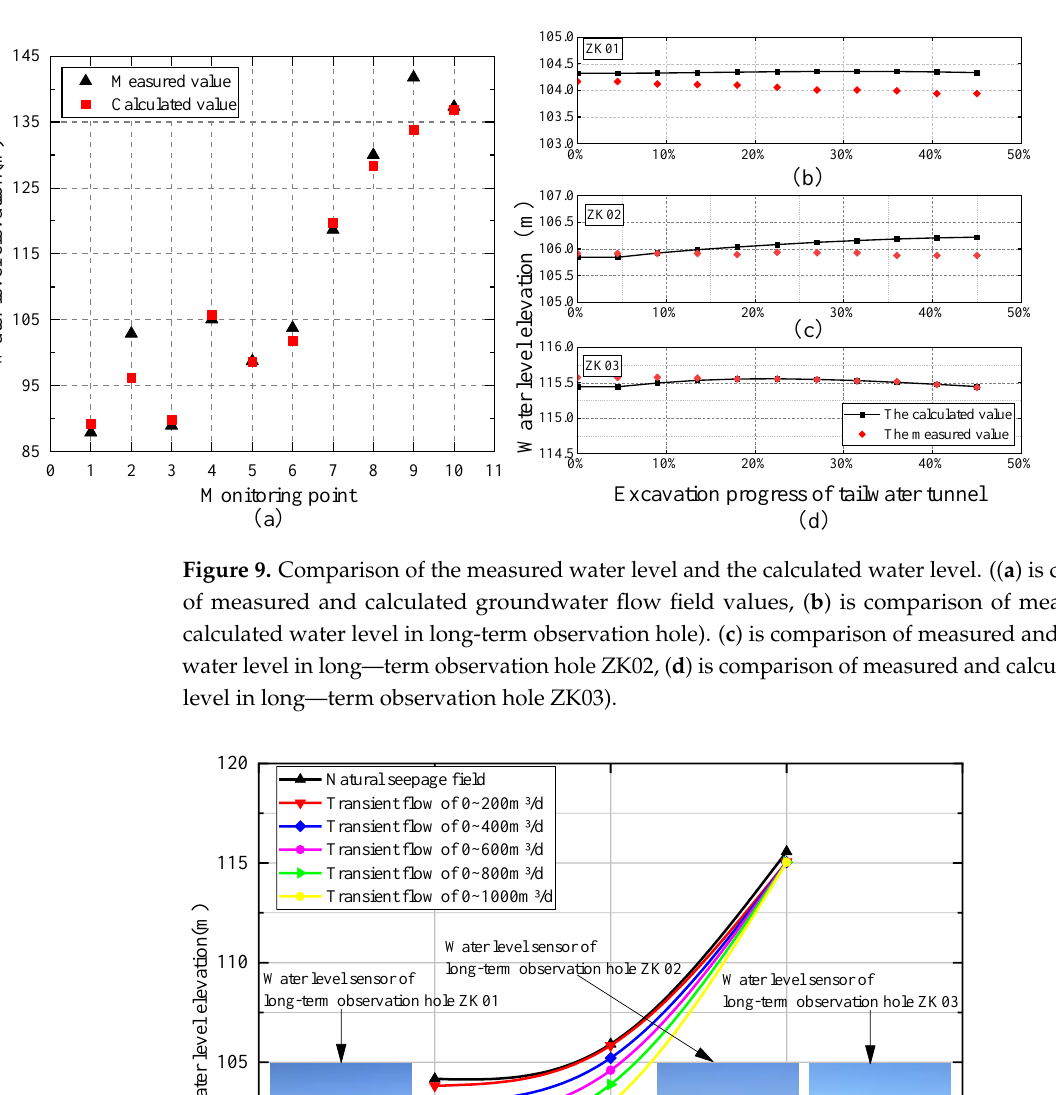
Figure 8. Comparison of ( a ) the natural seepage field and ( b ) the simulated seepage field. The measured and calculated water levels of the monitoring points are shown in Figure 9a. The simulated water level was roughly consistent with the field - measured water level, and the average error of the simulated calculated water level was 1.98%.